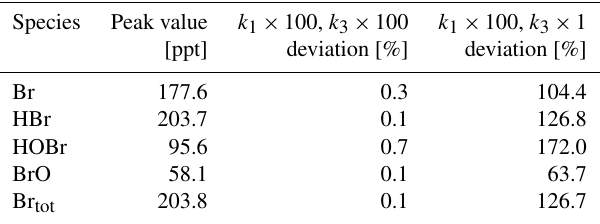
Table 5. Comparison of the peak values of principal bromine species calculated by using various chemical reaction mechanisms. The peak values shown in the table are calculated by using the re- duced reaction mechanism derived after the principal component